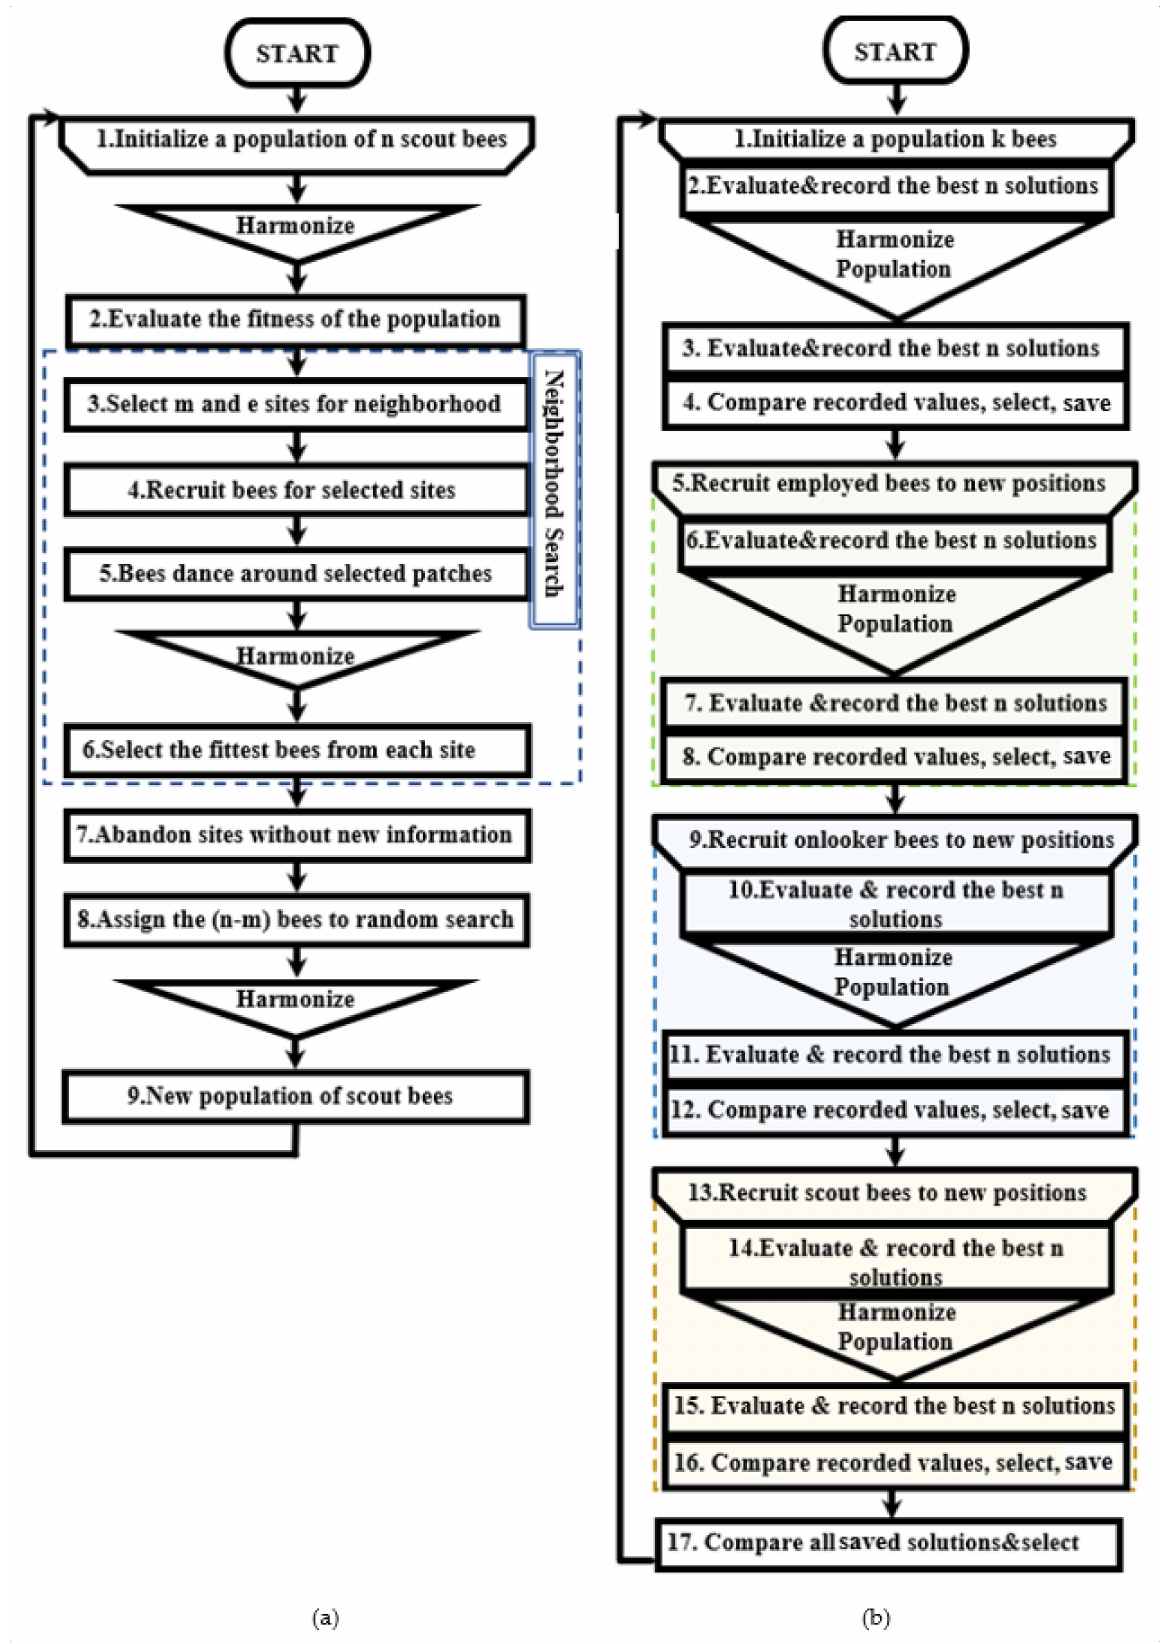
Figure 4. Algorithm procedures: ( a ) Harmonic Bee Algorithm, ( b ) Harmonic ABC